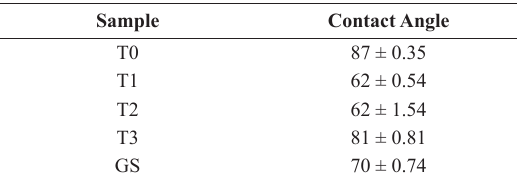
Table 3. Contact angle values obtained by the sessile drop method.